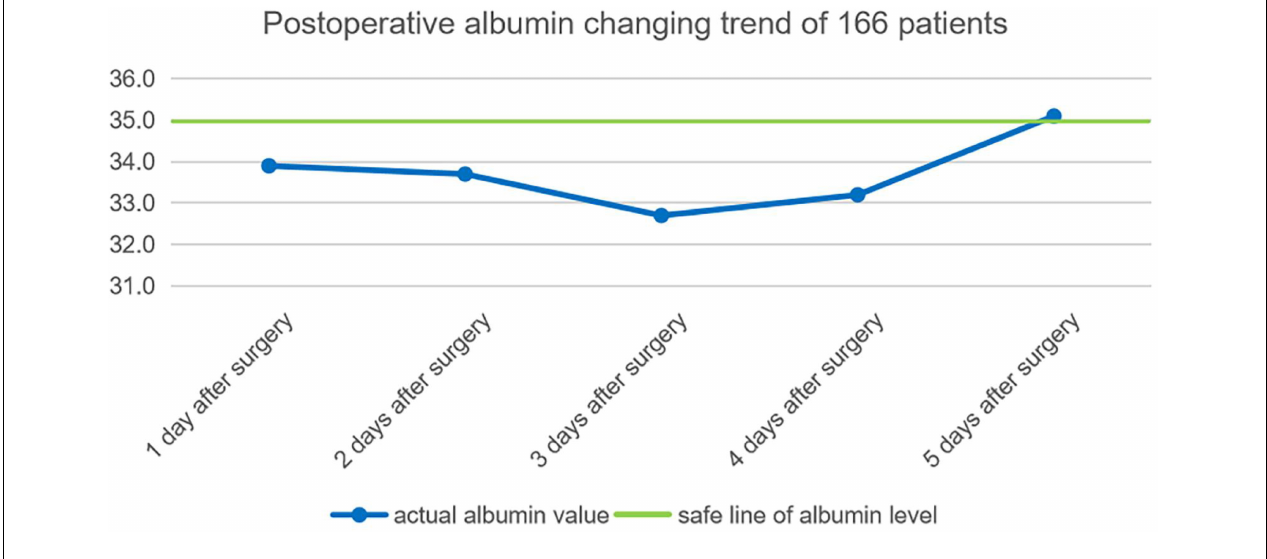
FIGURE 1 | Postoperative albumin changing trend of 166 patients.